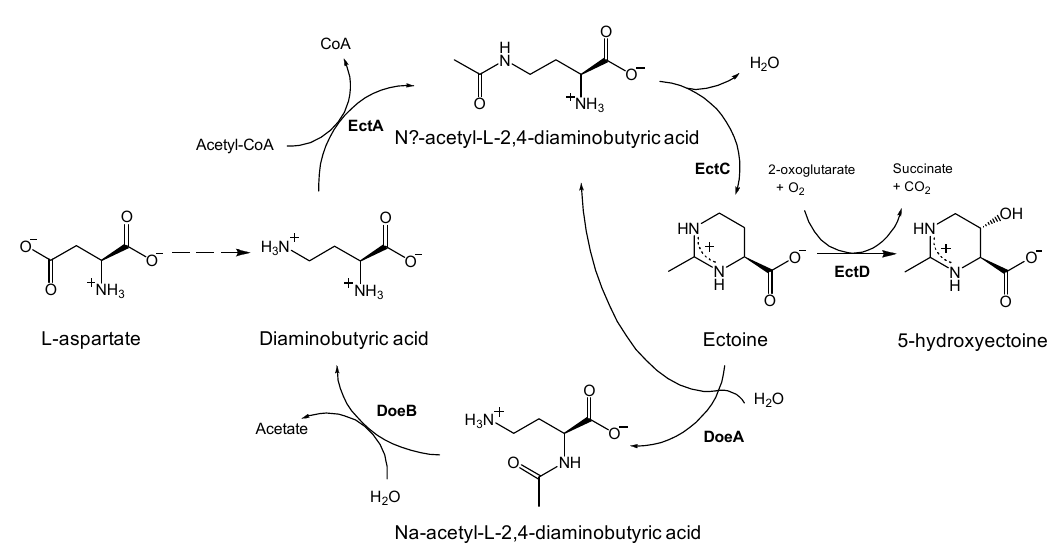
Figure 1. Ectoine synthesis pathway in H. elongata , starting with L-aspartate. N γ -acetyl-L-2,4- diaminobutyric acid ( γ -NADA) is enzymatically converted from diaminobutyric acid with the help of L-2,4-diaminobutyric acid transaminase (EctA). Ectoine synthase (EctC) catalyzes the ring formation to ectoine and ectoine hydroxylase (EctD), the hydroxylation to 5-hydroxyectoine. Ectoine hydrolase (DoeA) hydrolyses ectoine to N α -acetyl-L-2,4-diaminobutyric acid, and N α -acetyl-L-2,4- diaminobutyric acid deacetylase (DoeB) finally closes the cycle to diaminobutyric acid. Adapted with permission from [32].